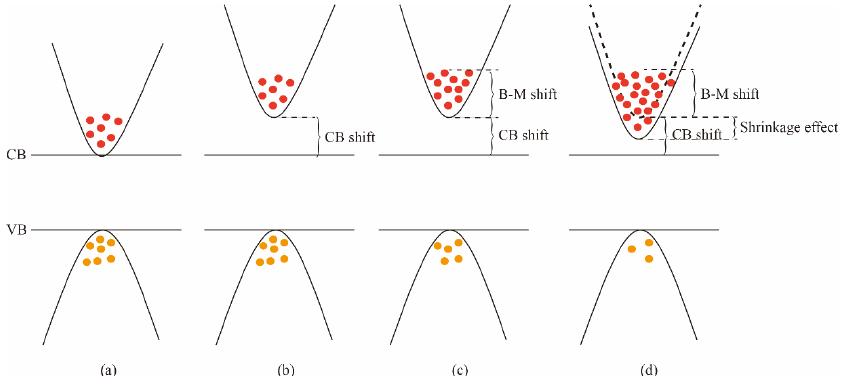
Figure 6. Schematic showing effect of doping on ZnO band structure. ( a ) Band structure of pure ZnO; ( b ) CB shift of band structure during doping; ( c ) both CB shift and B-M shift of band structure when the carrier concentration C < C Mott ; ( d ) CB shift, B-M shift, and shrinkage effect of band structure when the carrier concentration C > C Mott .